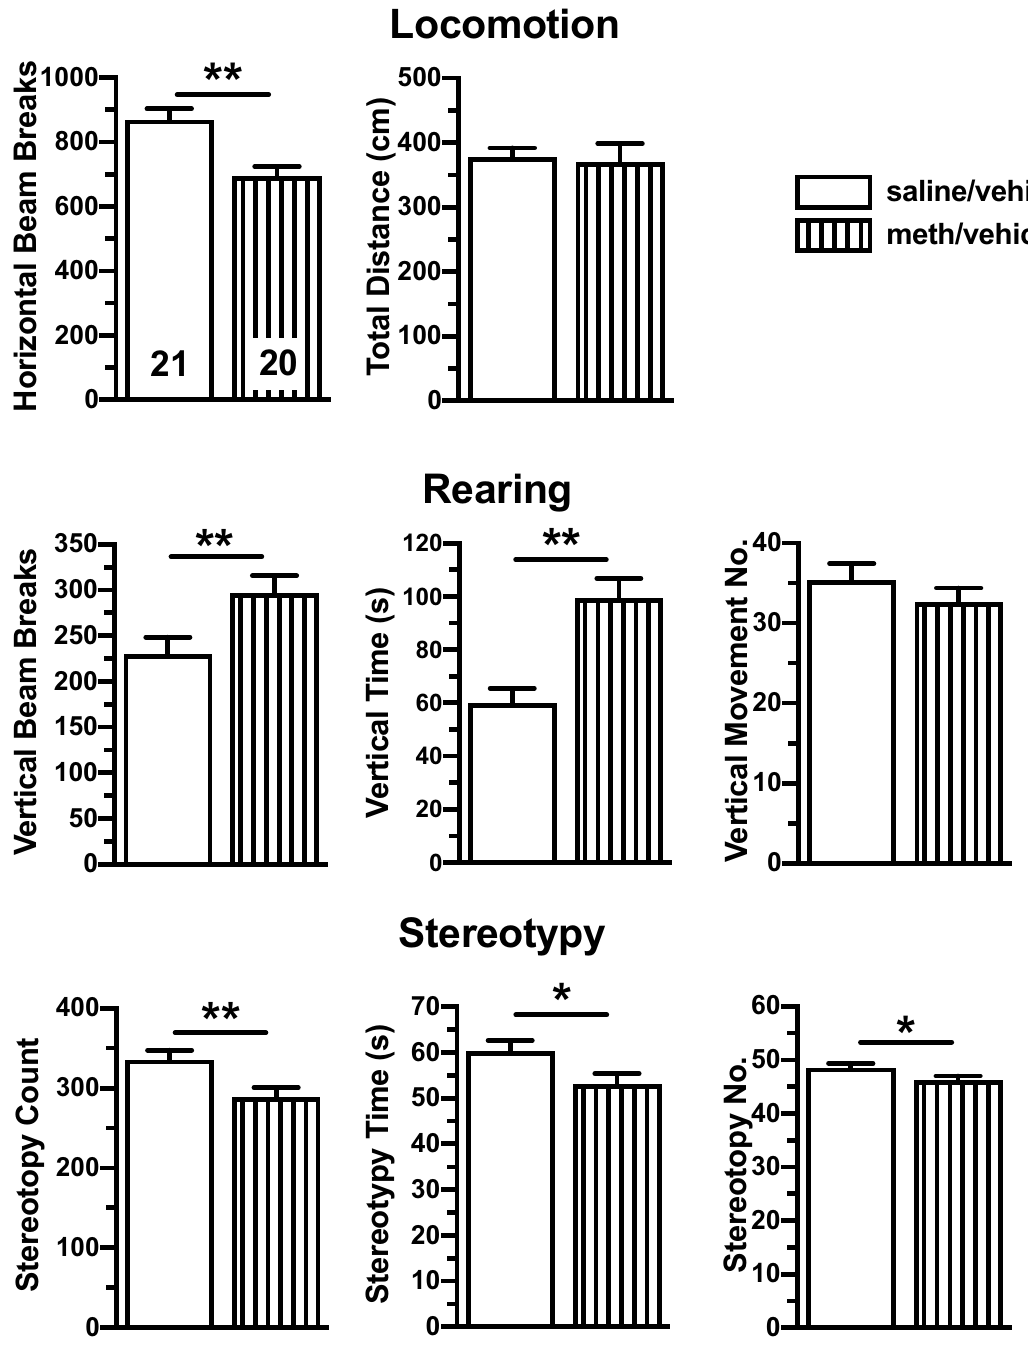
Figure 6. Peak effects of methamphetamine (meth)-induced behavioral sensitization. Vertical beam breaks and time were enhanced in meth/vehicle rats. Horizontal activity and stereotypy measures (count, time, and number) were reduced in meth/vehicle rats. One-tailed Student’s t-test, *p < 0.05, **p <